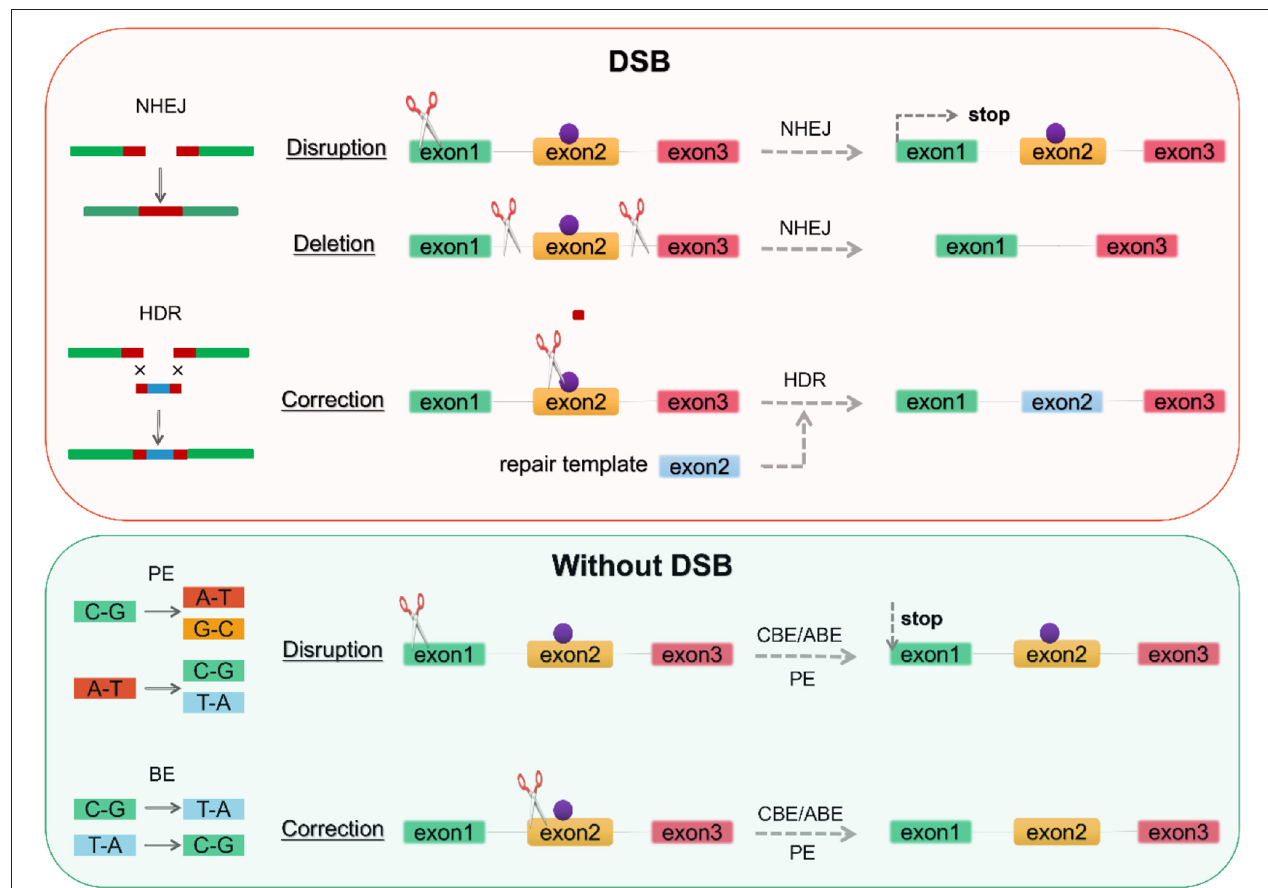
FIGURE 2 | Genome editing according to repair mechanism. DSBs induce two repair mechanisms, NHEJ and HDR. NHEJ can generate an indel at the gene of interest-based on gene disruption resulting in premature translation stop to achieve knockout, while gene deletion requires the creation of two DSBs on both sides of the pathogenic mutation (purple point). BE and PE can perform base substitution without DSBs, with the former being limited to 8 base substitutions and the latter enabling arbitrary base substitutions. DSB, double-strand breaks; NHEJ, non-homologous end joining; HDR, homologous directed repair; BE, base editor; PE,